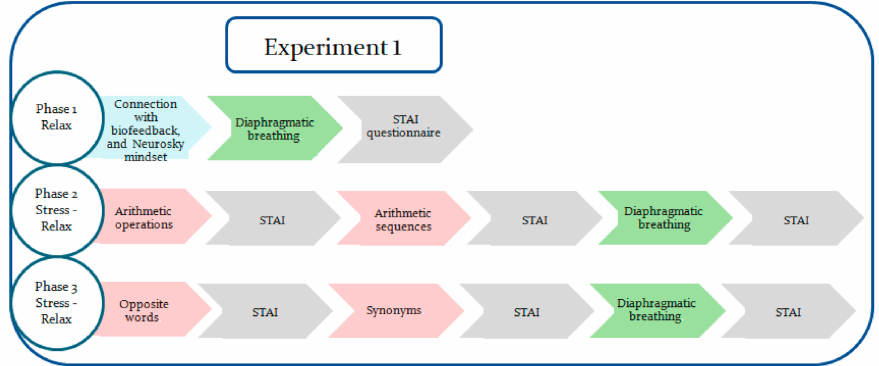
Figure 5. Procedure protocol of Experiment